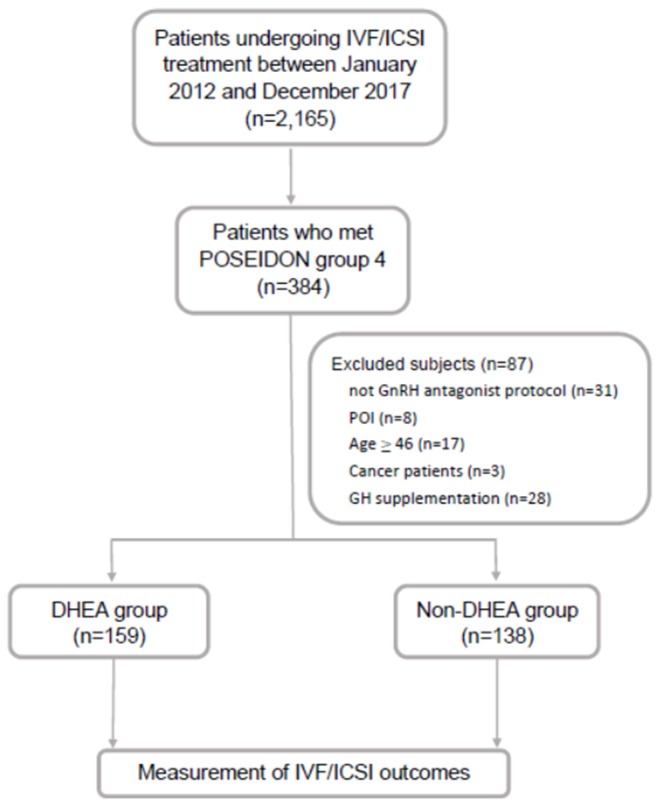
Flow chart of the study design. IVF, in vitro fertilization; ICSI, intracytoplasmic sperm injection; GnRH, gonadotropin-releasing hormone; GH, growth hormone; POI, primary ovarian insufficiency; DHEA, dehydroepiandrosterone.